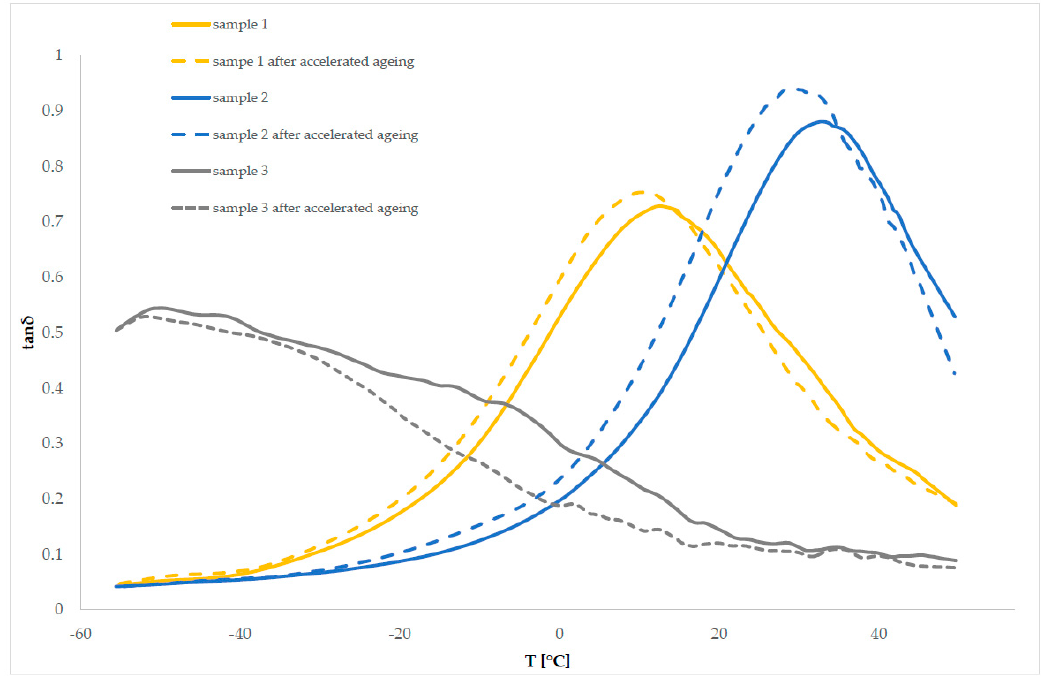
Figure 6. Mechanical loss factor tan δ in relation to the temperature for sample 1, sample 2, and sample 3, before and after the process of accelerated